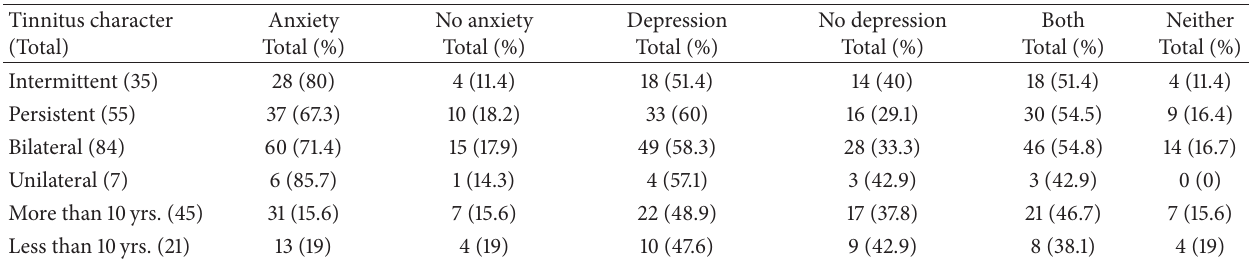
Table 3: Tinnitus characteristics and